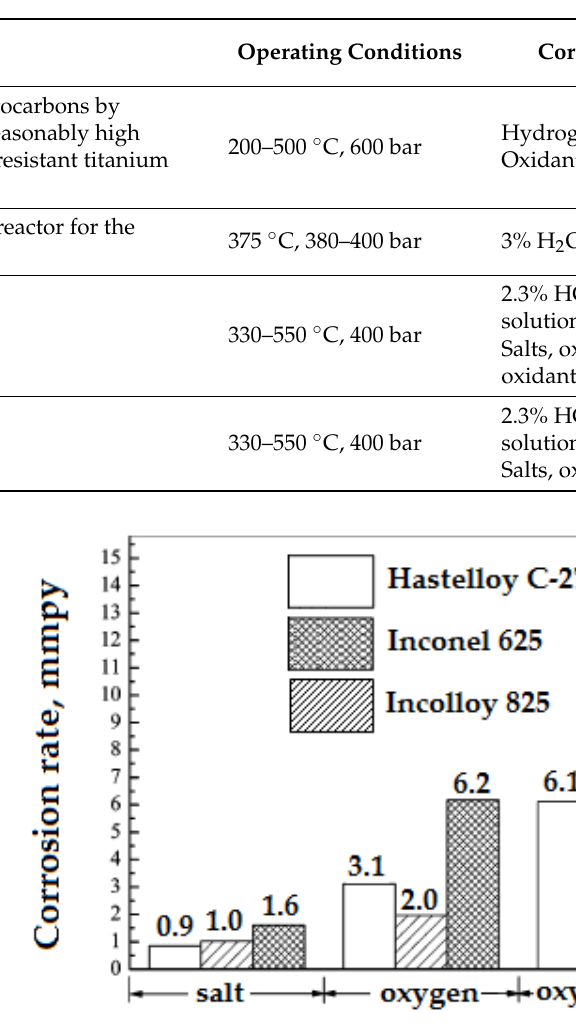
Table 7. Corrosion rates for different SCWO reactors.